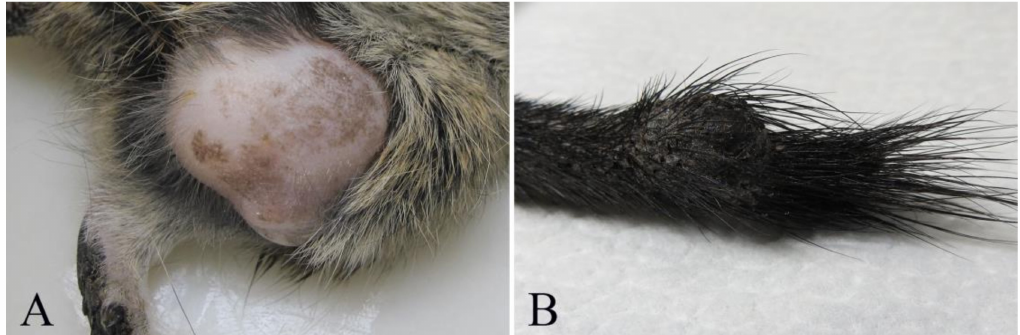
Figure 1. Tumors in pet degus ( Octogon degus ). ( A ) Subject # 2. Fibrosarcoma, large neoplastic mass